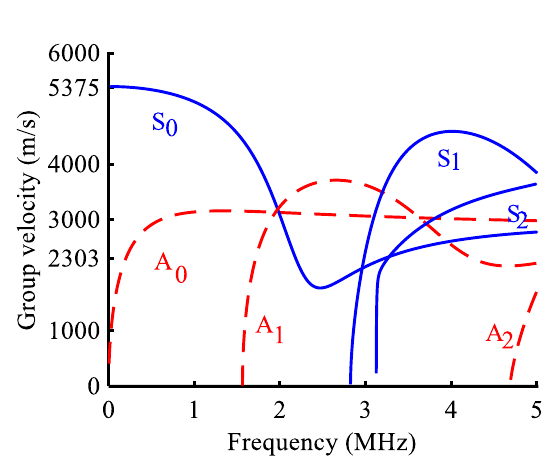
Figure 4 Group velocity dispersion curve in 1-mm-thick aluminum